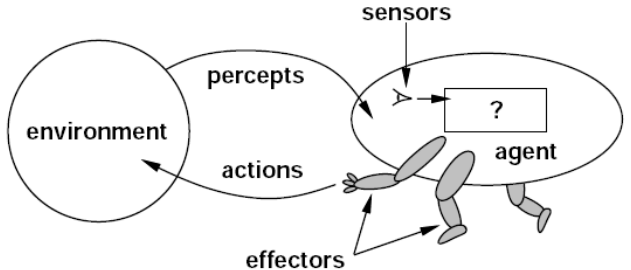
Figure 1. An illustration of an intelligent agent. The agent can be a robot or a software agent. A robot agent, for example, can perceive its environment through sensors and act on that environment through effectors.